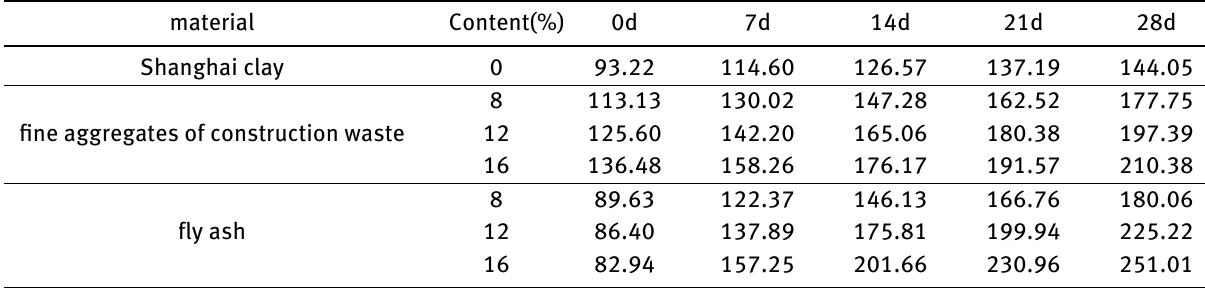
Table 7: Unconfined compressive strength of clay samples reinforced with different admixtures (kPa).